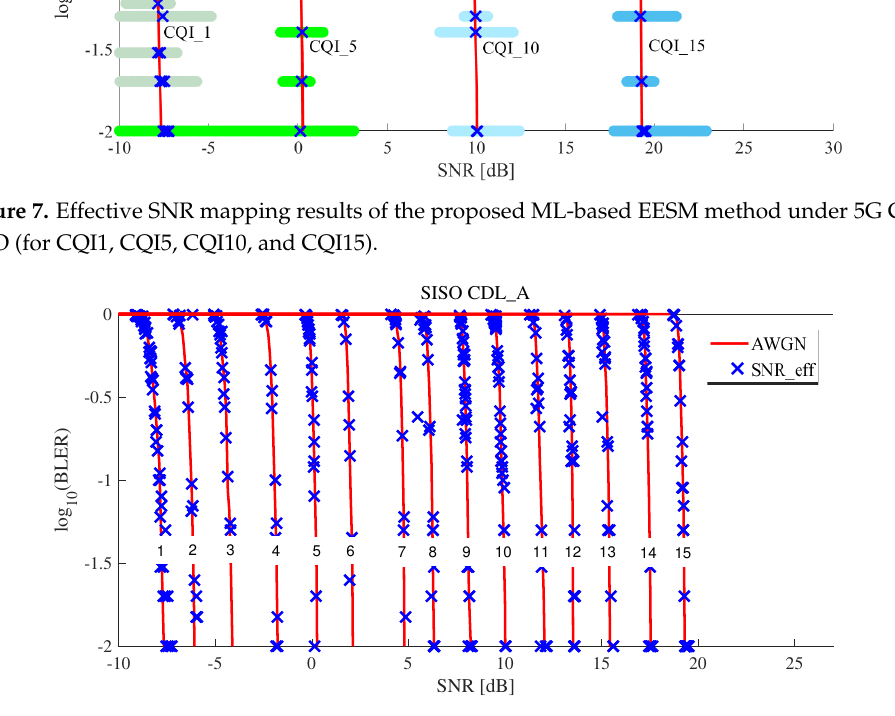
Figure 8. Effective SNR mapping results of the proposed ML-based EESM method under 5G CDL-A SISO for all